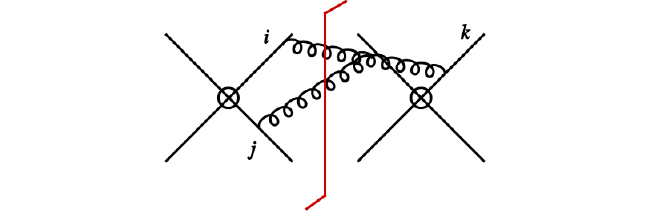
Figure 7 . Three-Wilson-line, double cut diagram appearing in the calculation of the NNLO soft function.